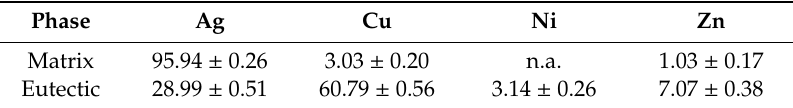
Table 3. Alloy phases compositions measured via energy dispersive spectroscopy (EDS); each element concentration is expressed in (wt %).